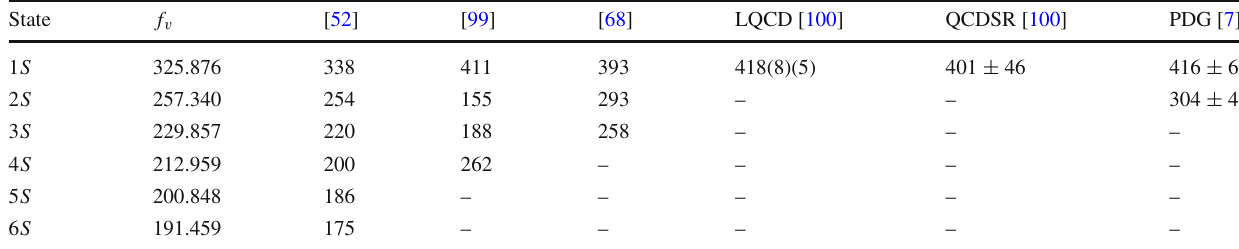
Table 9 Vector decay constant of charmonia (in MeV)